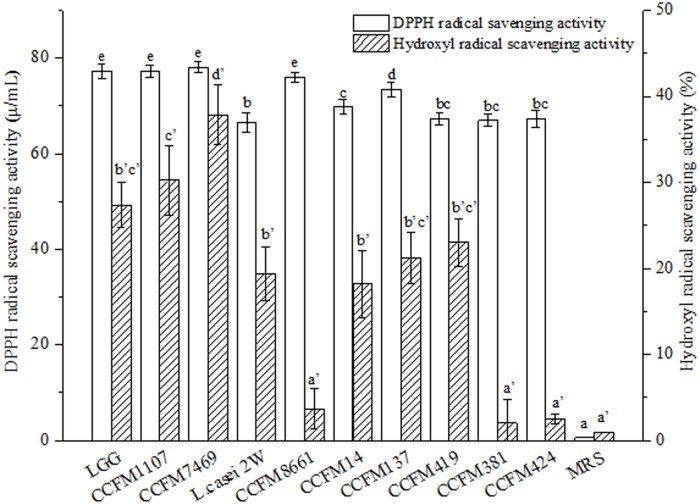
DPPH and HRS activities of the CFSs (mean ± SD, n = 3).MRS broth control sample without Lactobacillus. The letters a, b, c, d, and e indicate statistically significant difference at p < 0.05 within each row comparison between the DPPH radical scavenging groups. The letters a’, b’, c’, d’, and e’ indicate statistically significant difference at p < 0.05 within each row comparison between the HRS groups. Bars with no common letters are significantly different (p < 0.05).